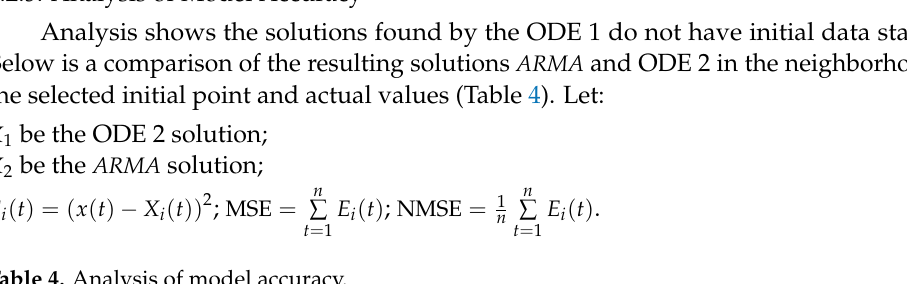
Table 4. Analysis of model accuracy.